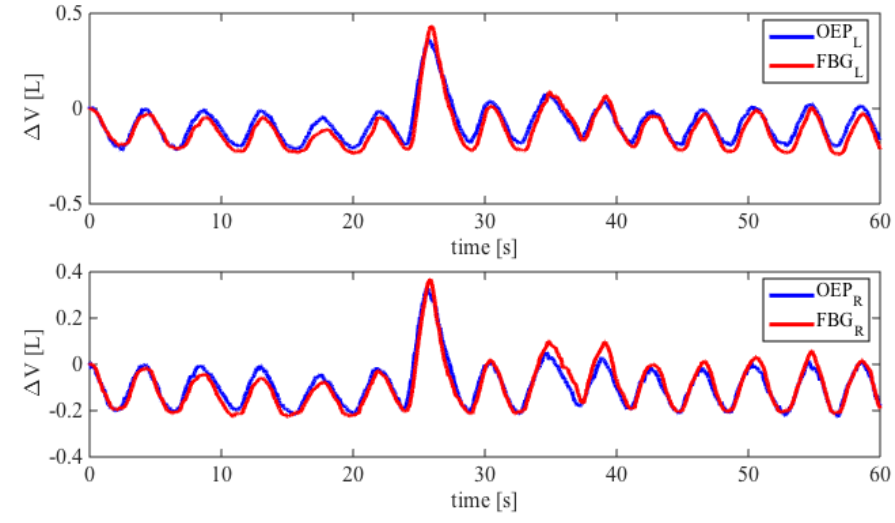
Figure 6. Comparison between the FBGs wavelength changes and UT volume considering both left and right side. The best fitting lines are also